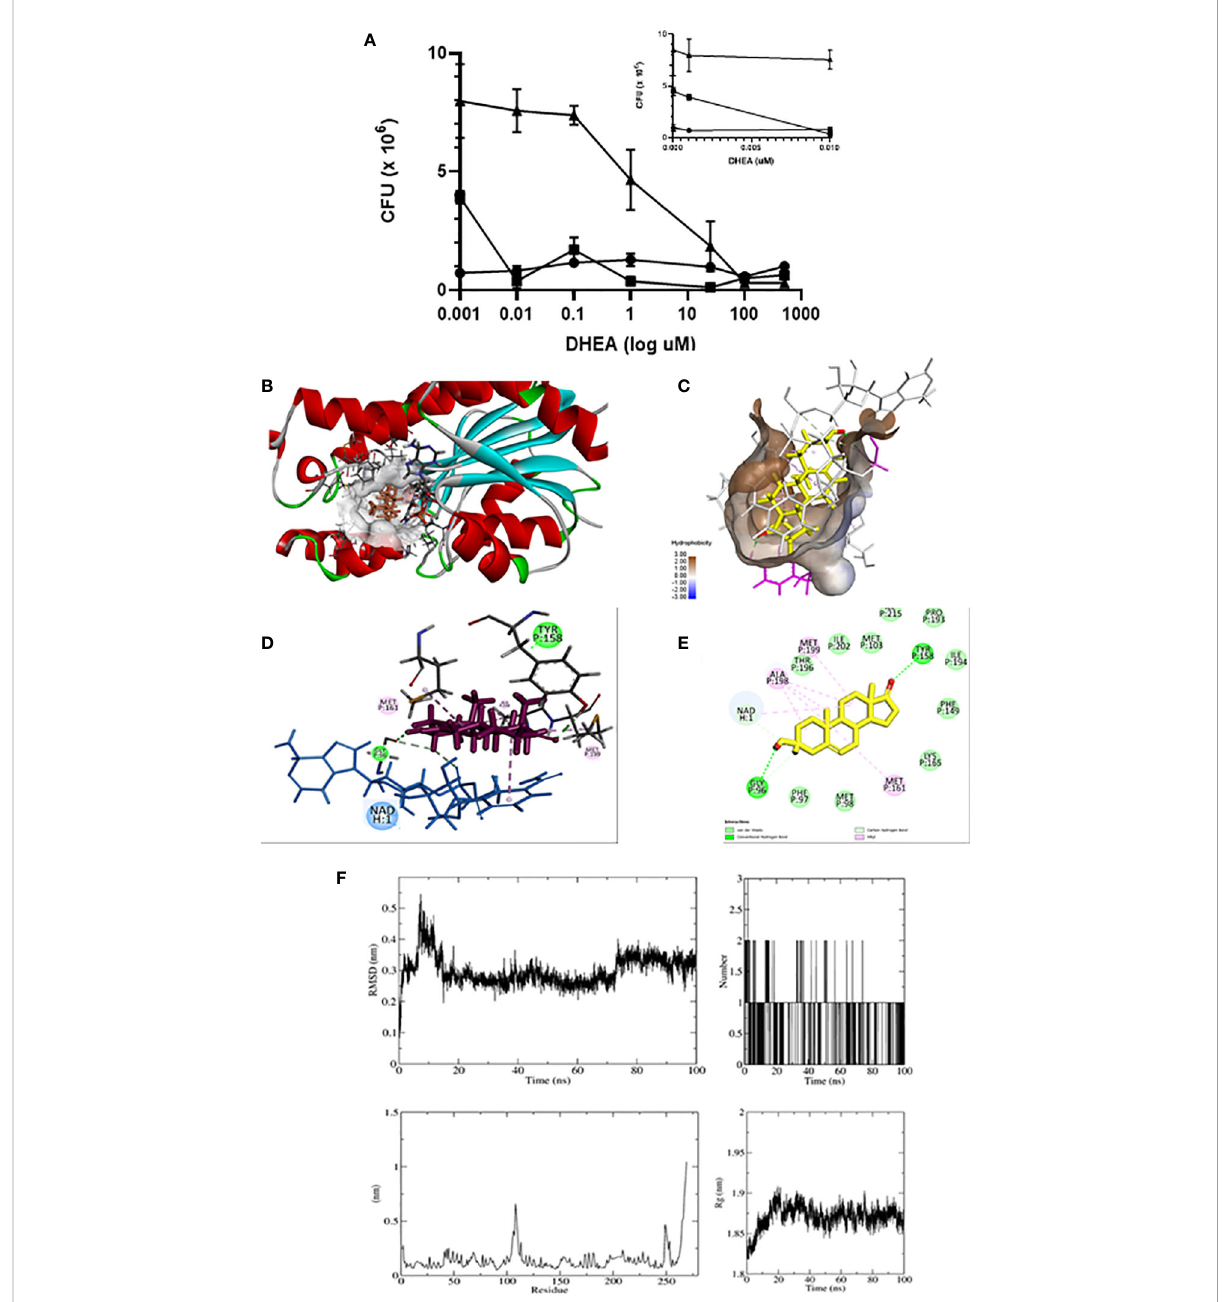
FIGURE 6 DHEA has microbicide effect on Mtb through interaction with InhA. Anti-mycobacterial activity of DHEA was evaluated by CFUs using the minimum inhibitory concentration (MIC) assay. Incubations time of Mtb with DHEA. (- ● - T = 1, - ■ - T = 2, - ▲ - T = 3 days). The insert in the arithmetic scale shows UFC in the absence and presence of the lowest DHEA concentrations (A) . Molecular docking shows that DHEA interacts with InhA enzyme of Mtb in the active site in the presence of cofactor NADH (B) . The hydrophobic pocket is shown (C) . The 3D representations (D) and 2D diagram (E) of InhA interacting with DHEA display its interactions by two hydrogen bonds with Tyr 158 and Gly95 in the active site. Molecular dynamic (MD) simulation studies showing the stability of the protein-ligand complex between InhA and DHEA: RMSD plot, Radius of gyration (Rg) plot, RMSF plot, and hydrogen bonds throughout the simulation (F)